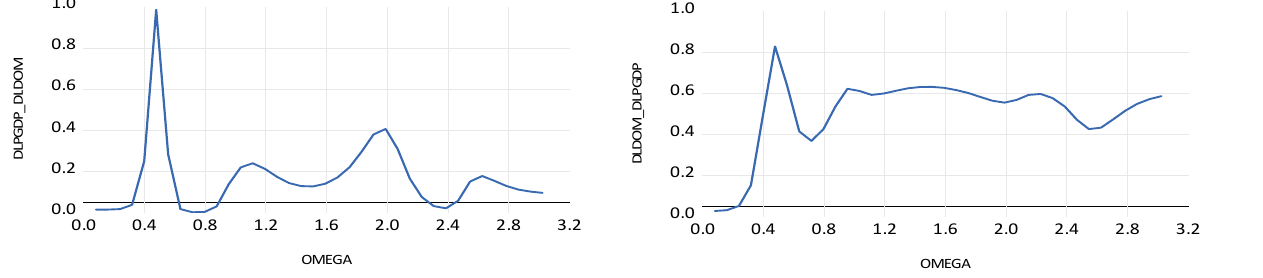
Figure 4: Causality from DLDOM → DLPGDP in the left and from DLPGDP → DLDOM in the right